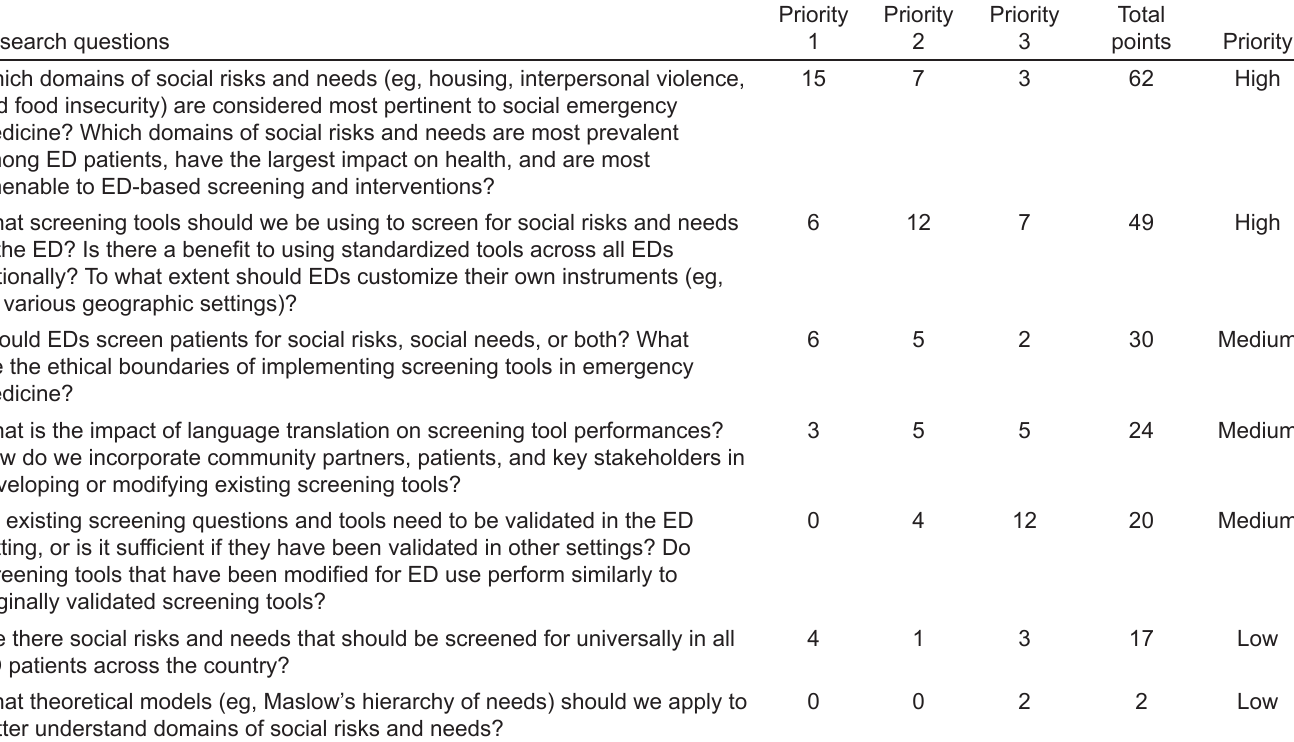
Table 1. Final ranked research priorities pertaining to instruments used for social risks and needs screening in the